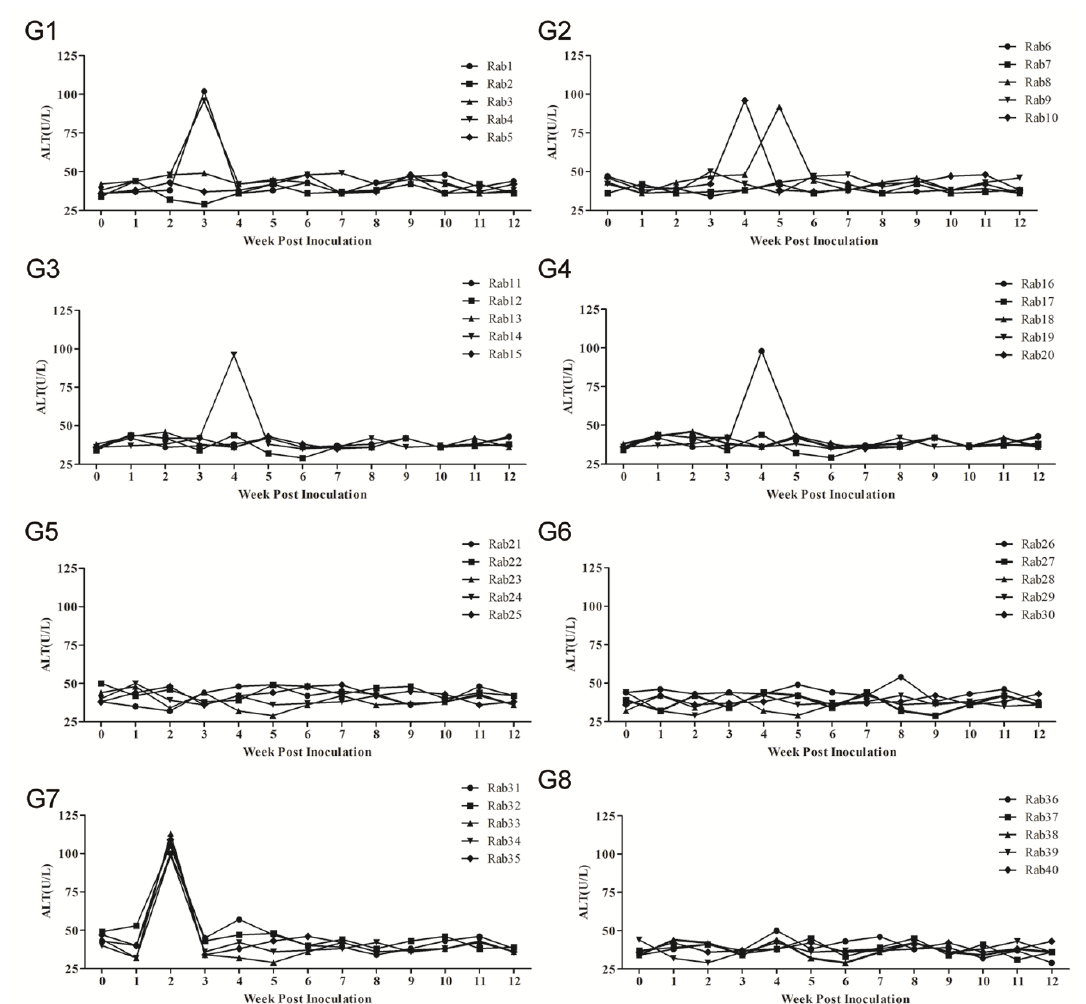
Figure 5. Levels of ALT liver enzyme in sera of inoculated rabbits in different groups. SPF rabbits immunized with Pep VKLYTS ( G1 ), Pep PSRPF ( G2 ), Pep EPTV ( G3 ), Pep EPTVKLYTS ( G4 ), Pep EPTVKLYTSPSRPF ( G5 ), sp239 protein ( G6 ), or PBS (( G7 ), negative control); Rabbits challenged with PBS ( G8 ) as a normal control. Compared with the normal group 8, the mean aminotransferase (ALT) values from the 5 rabbits in group 7 were significantly higher at 2 wpi (n = 5, p < 0.05). p -values were calculated using Student’s t- test.